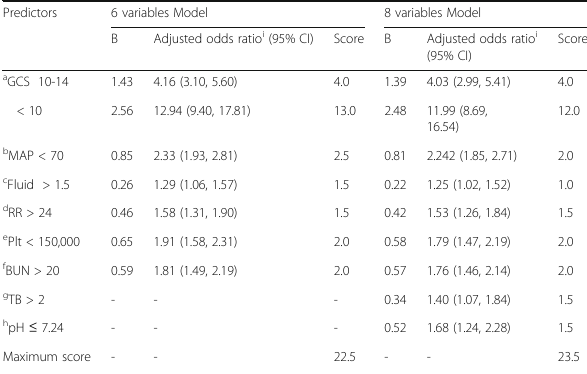
Table 1 (abstract P5). Creating the THAI-ICU score of development cohort with multivariable regression-based method